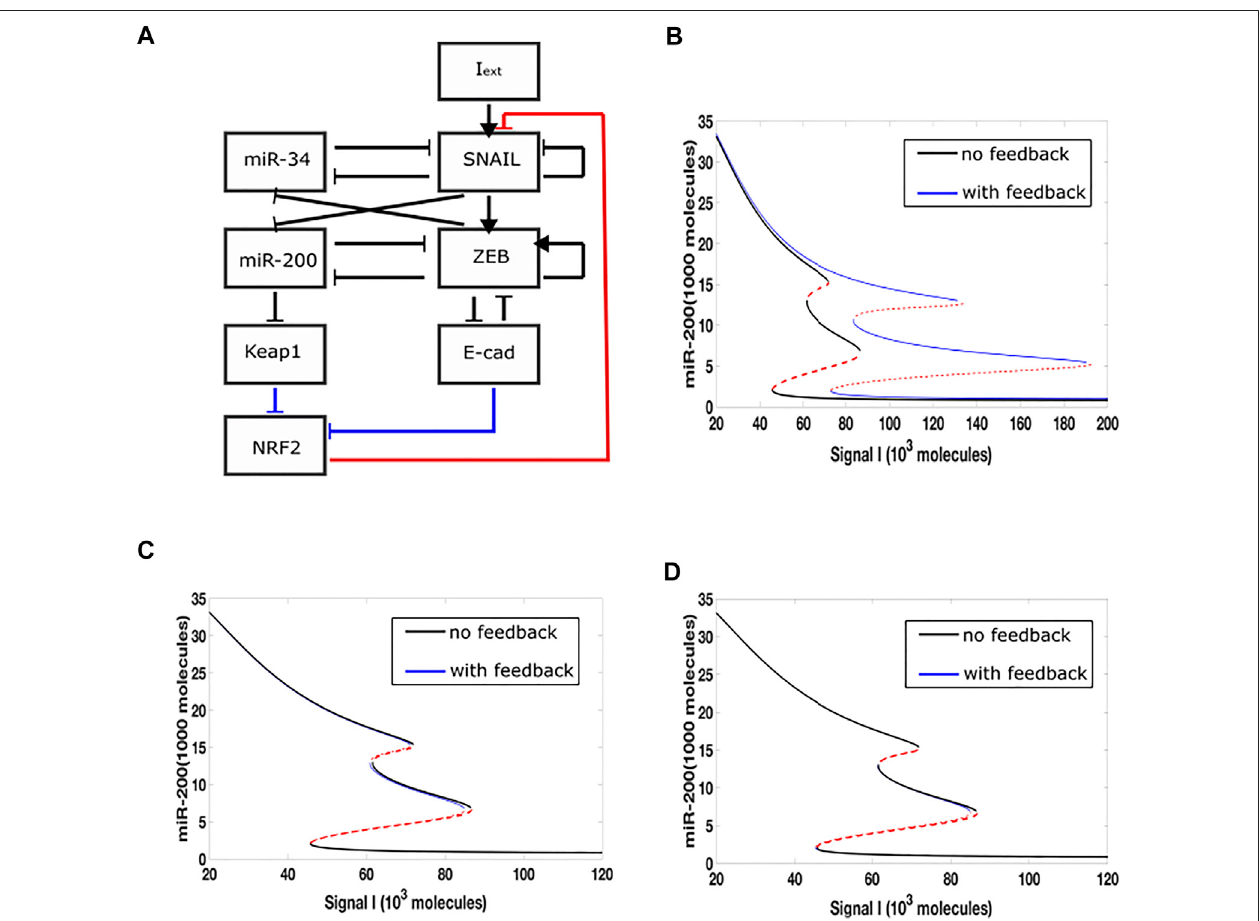
FIGURE 1 | Epigenetic feedback-mediated dynamics of NRF2 coupled to core EMT circuitry. (A) A regulatory network for EMT that consists of two microRNA-TF mutuallyinhibitorycircuits:miR-34/SNAILand miR-200/ZEB. SignalIrepresents externalEMT-inducingsignalssuchasHGF, NF- κ B,Wnt,TGF- β and/or HIF1 α .NRF2 module is added to the core networks by three distinct links. Blue links represent the inhibition from Keap1 and E-cad on NRF2 respectively, and the red link represents the inhibition on SNAIL from NRF2. (B – D) Bifurcation diagrams of miR-200 levels for the network shown in Panel 1A, with I as the bifurcation parameter. Solid lines represent stable states, dashed lines represent unstable states. Black lines correspond to the circuit without epigenetic regulation, and blue lines correspond toa circuit including epigenetic feedback. In (B) , the epigenetic feedback is on the inhibition of SNAIL by NRF2. In (C) , the epigenetic feedback is on the inhibitory link from E-cadherin to NRF2. In (D) , the epigenetic feedback is on the inhibtion of NRF2 by Keap1.